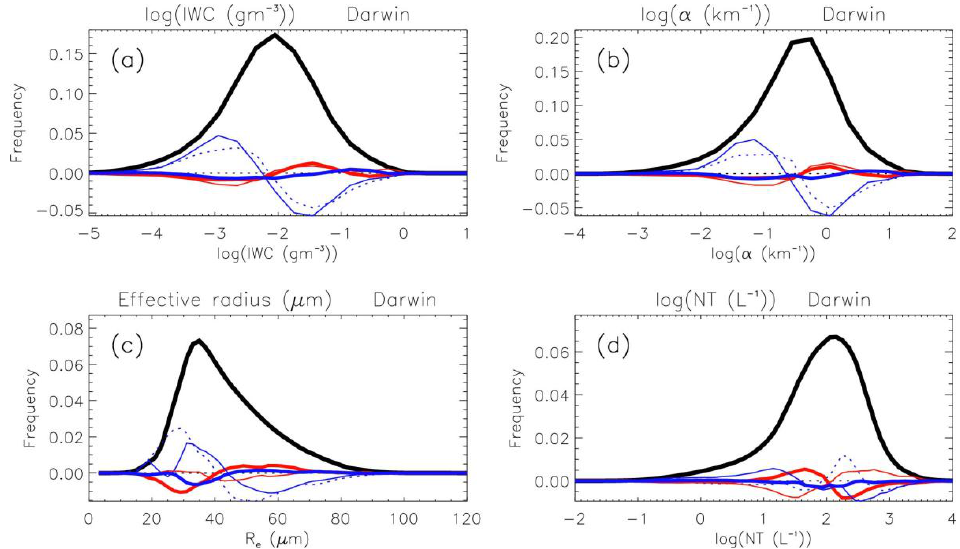
Fig. 7. PDFs of the microphysical and radiative properties of ice clouds: (a) ice water content (in gm − 3 ) , (b) visible extinction (in km − 1 ) , (c) effective radius (in µm) and (d) total concentration (in l − 1 ) over Darwin with all regimes included (thick black line), and PDF difference (regime-total) for the following large-scale atmospheric regimes: Moist Easterly (thick blue line), Easterly (thin solid blue line), Dry Easterly (thin dotted blue line), Active monsoon (thick red line), and Shallow Westerly (thin red line).